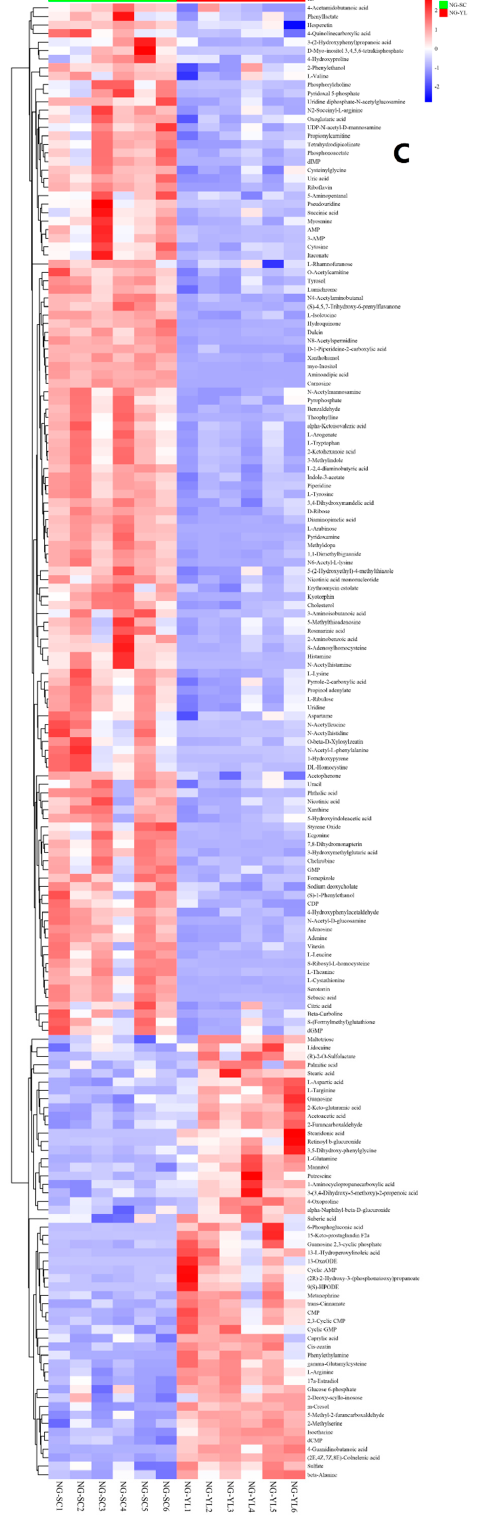
Figure 5. Metabolome analysis of the SCs and YL in Aureobasidium pullulans NG. ( A ) PLS − DA plots between the treated group (SCs) and the control group (YL). ( B ) OPLS − DA plots between the treated group (SCs) and the control group (YL). POS and NEG represent the positive and negative ion modes of mass spectrometry, respectively. ( C ) Hierarchical cluster and heatmap displaying the abundances levels of DAMs in all the